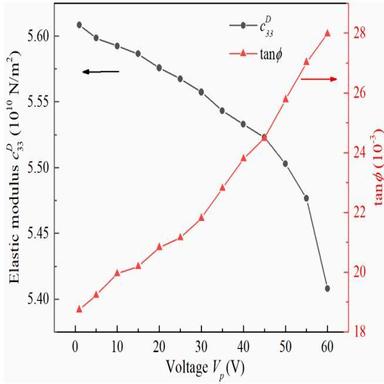
The elastic modulus cD 33 and the elastic loss factor tanϕ33 of the PMN-PT composite as a function of the AC driving voltage.